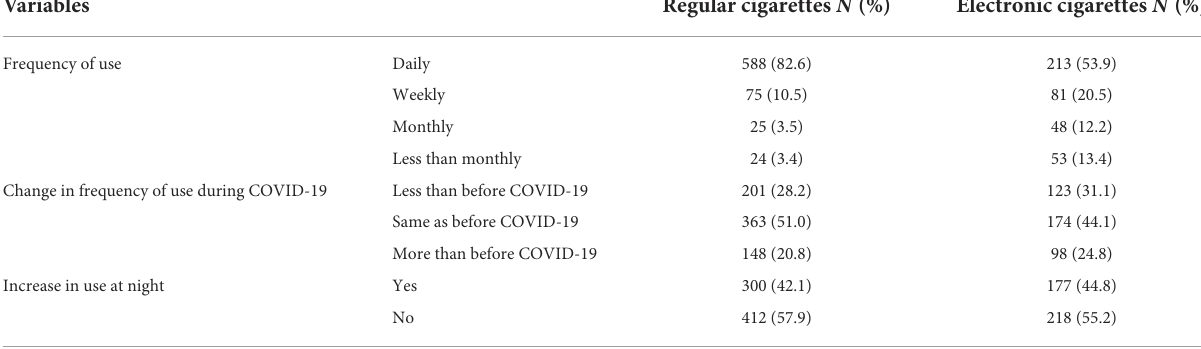
TABLE 2 Characteristics of using regular cigarettes ( n = 712) and electronic cigarettes ( n = 395). Variables